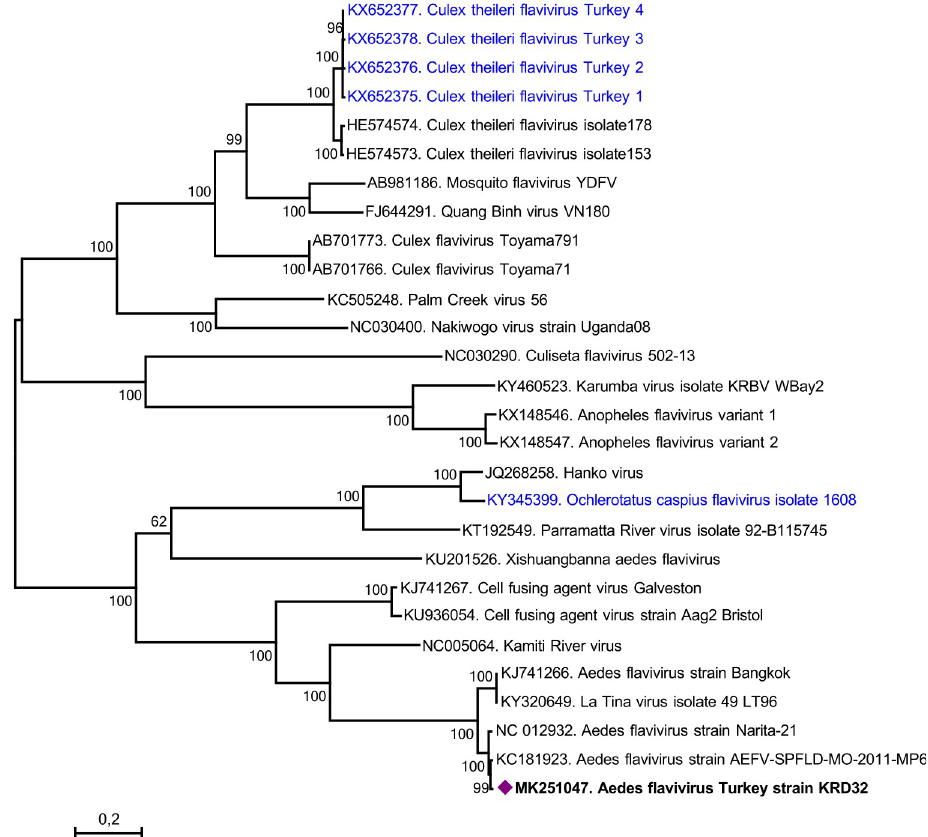
Fig 4. The maximum likelihood analysis of the near-complete polyprotein coding region (10766 nt) of selected insect-specific flaviviruses. The tree is constructed using Maximum Likelihood method with the General Time Reversible (GTR) model, Gamma distributed with Invariant sites (G+I) for 1000 replications. The sequence characterized in this study are given in bold and indicated with a symbol, GenBank accession number, virus and isolate/strain name. Global virus strains are indicated by GenBank accession number, virus and strain/isolate name. Viruses previously characterized in Turkey are indicated with blue letters. Bootstrap values higher than 60 are